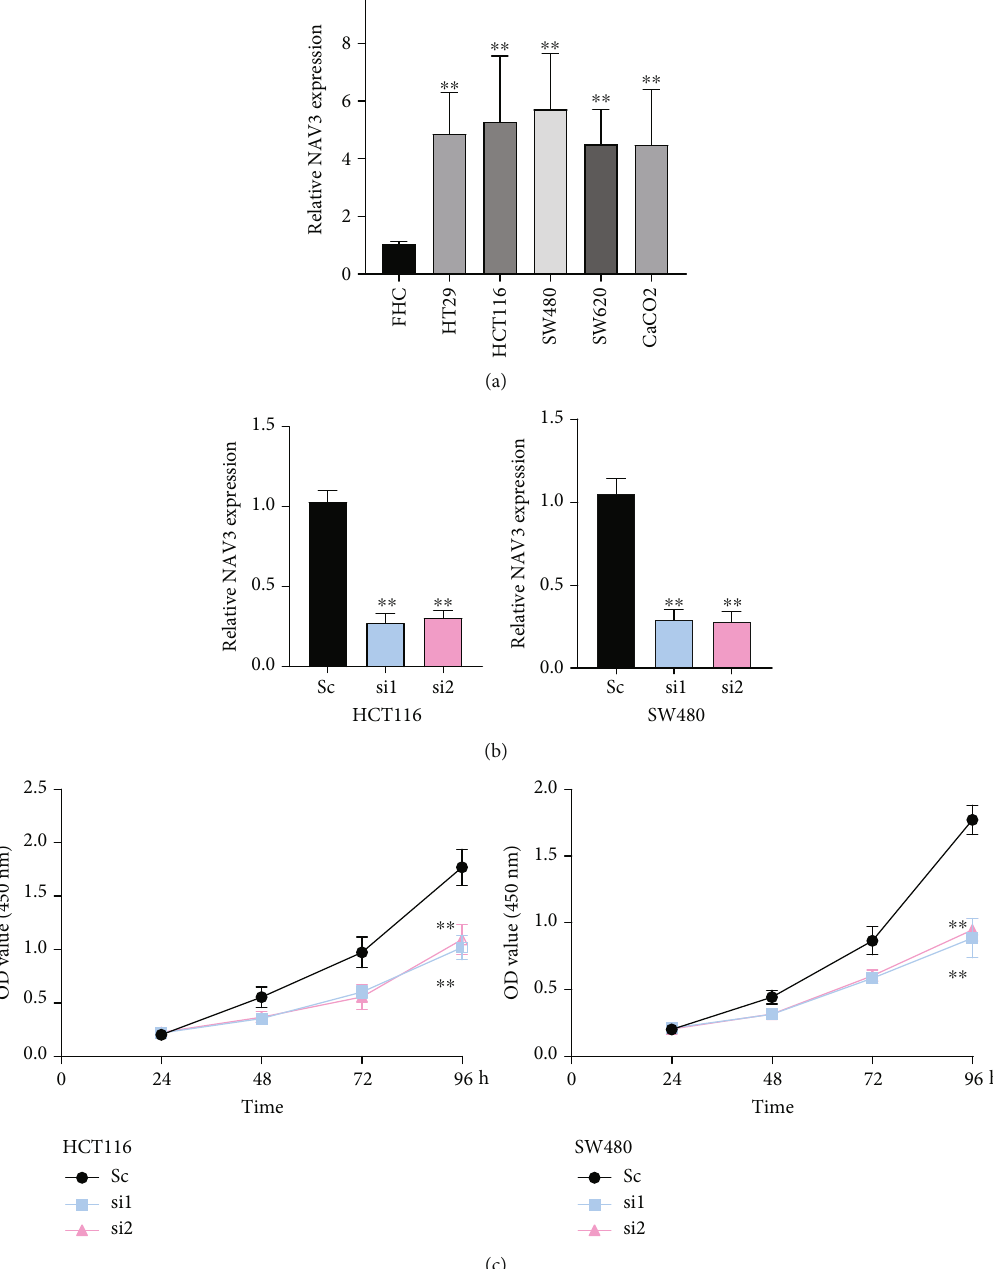
Figure 9: NAV3 promoted CRC cell proliferation in vitro. (a) NAV3 expressions in fi ve CRC cells examined via RT-qPCR. (b) The e ffi ciency of NAV3 silencing was examined through RT-qPCR in the HCT116 and SW480 after the transfection with siRNAs. (c) CCK-8 experiments con fi rming that silencing of NAV3 inhibited the proliferation of HCT116 and SW480 cells. ∗∗ p < 0 : 01